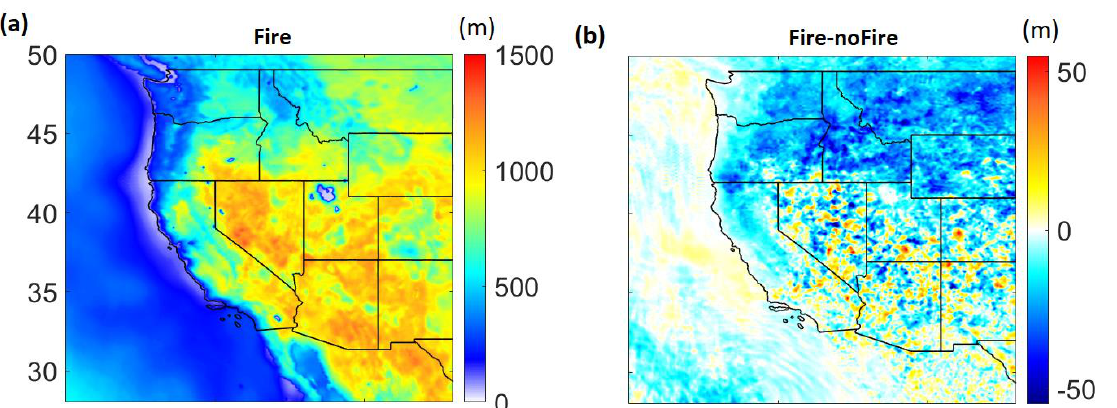
Figure 8. Spatial distribution of ( a ) average 2 m temperature in ° C for ‘Fire’ simulation, ( b ) average difference between ‘Fire’ and ‘noFire’ simulations in °C, for the first half of September 2017.